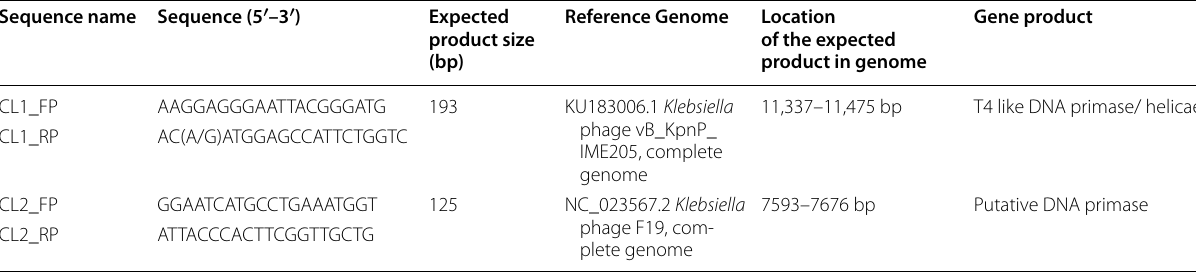
Table 1 Details of primers used in the study Sequence name Sequence (5 ′ –3 ′